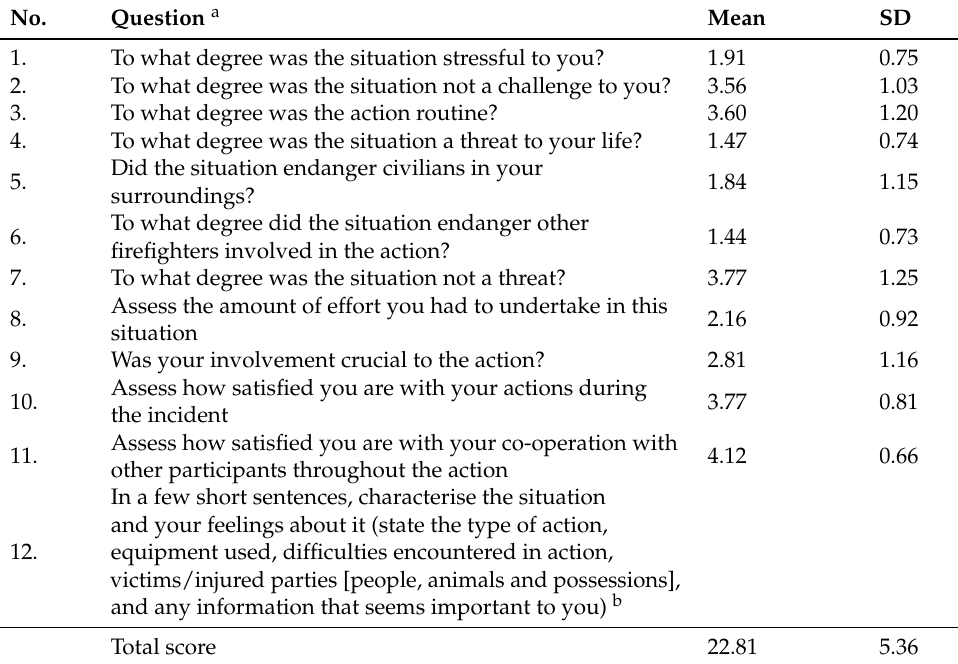
Table 2. Results of self-assessment of stress experienced upon emergency events. Mean score and SD calculated for each position of the questionnaire and for the total